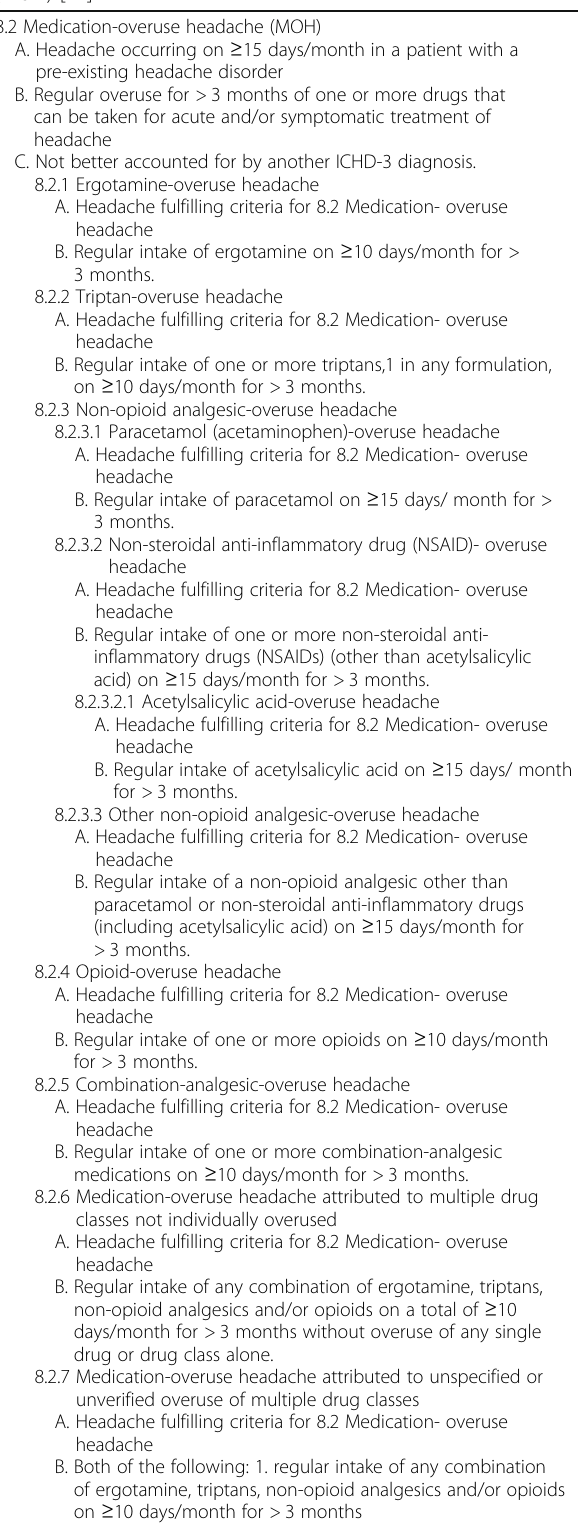
Table 1 International Classification of Headache Disorders Third Edition (ICHD-3) Criteria for Medication-Overuse